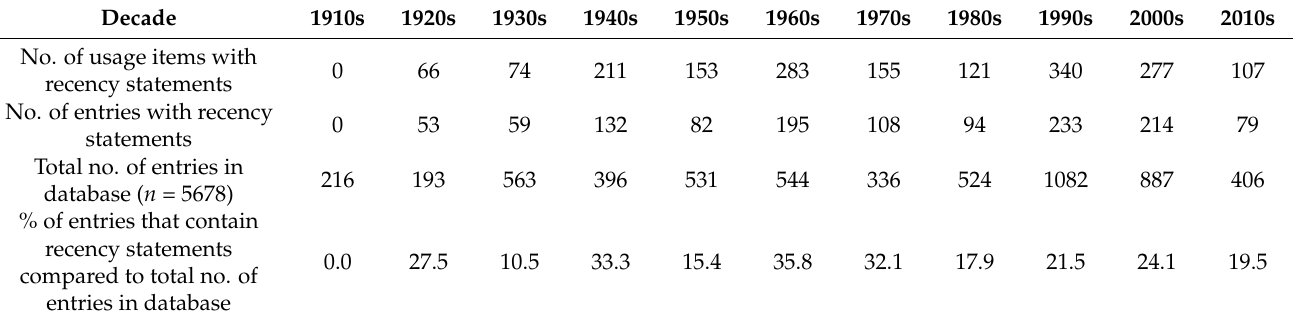
Table 4. Frequency statements per decade as raw frequency and percentage of total amount of